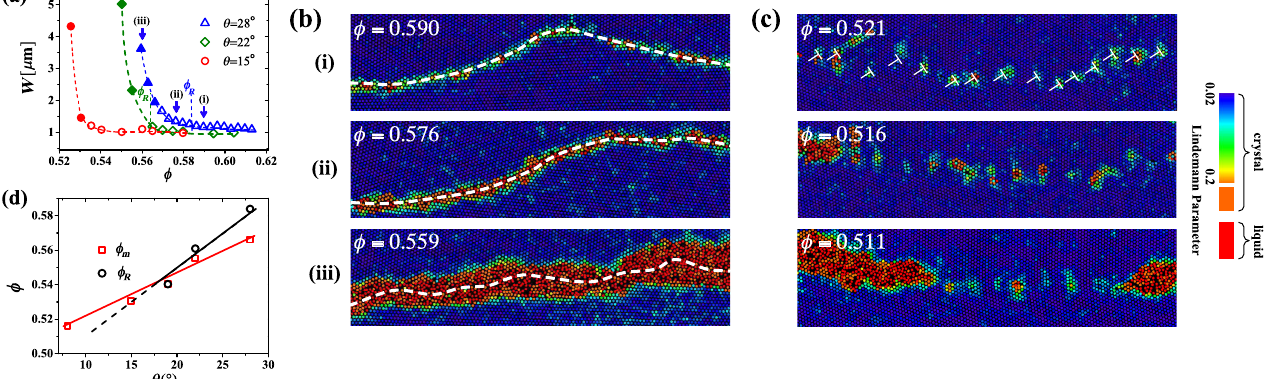
FIG. 3. Grain-boundary widening and melting. (a) Widths of three grain boundaries with θ ¼ 28 °, 22°, and 15°. The vertical dashed lines mark the roughening points. (b) The grain boundary with θ ¼ 28 ° colored according to the dynamic Lindemann parameters L (see SM for definition) at (i) preroughening, (ii) postroughening, and (iii) melting labeled in (a) (Movie 1 in Ref. [26]). Liquidlike particles are identified by large dynamic Lindemann parameters L > 0 . 2 and low bond-orientational orders j ψ 6 j < 0 . 6 [41]. The particles keep swapping positions with neighbors (Movie 1) and thus are indeed liquidlike. The white dashed curve represents the center of the grain boundary. (c) The grain boundary with θ ¼ 8 ° is composed of dislocations labeled with ⊥ (Movie 2 in Ref. [26]). (d) The roughening points and melting points of grain boundaries with different mismatch